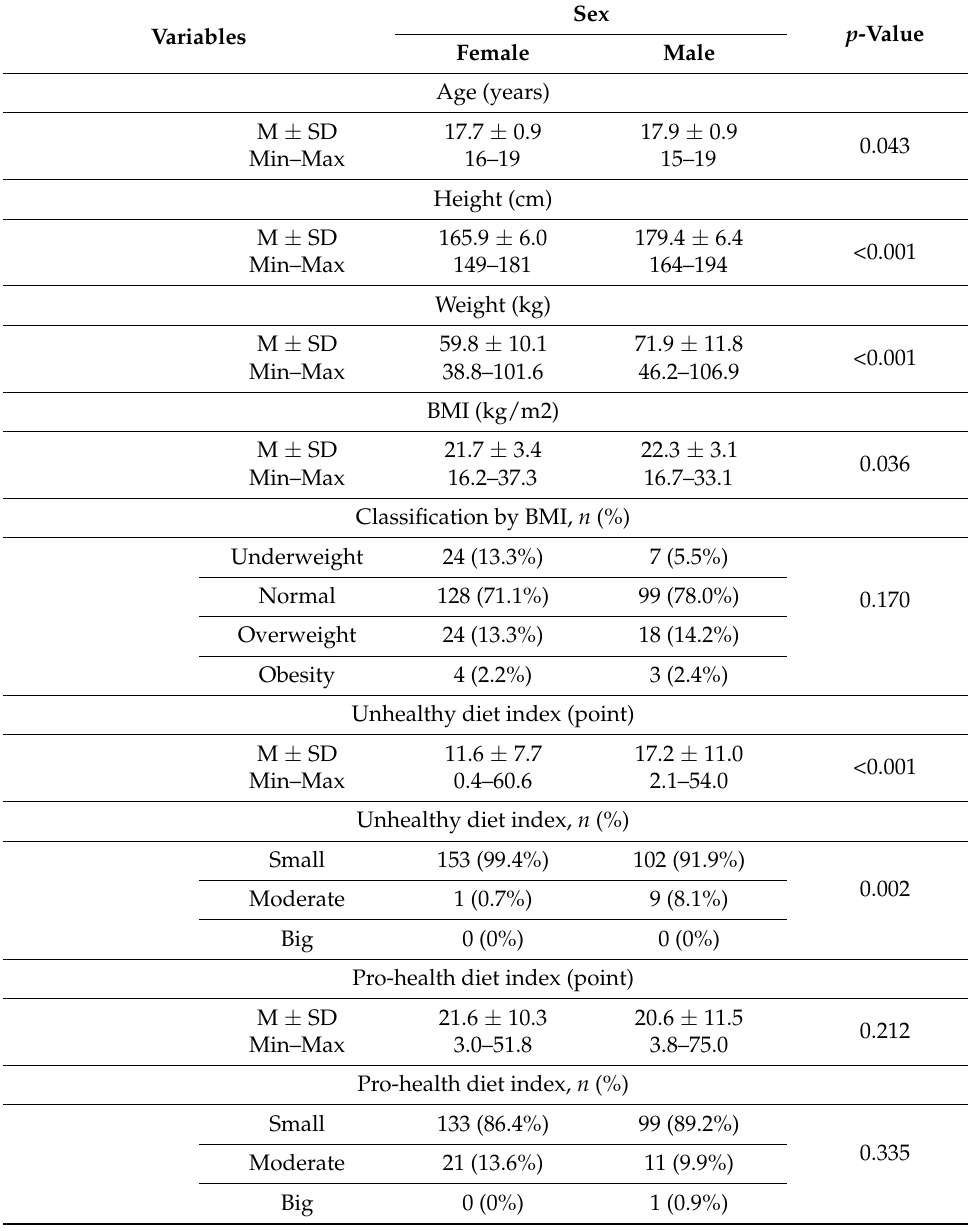
Table 1. Baseline characteristics of study